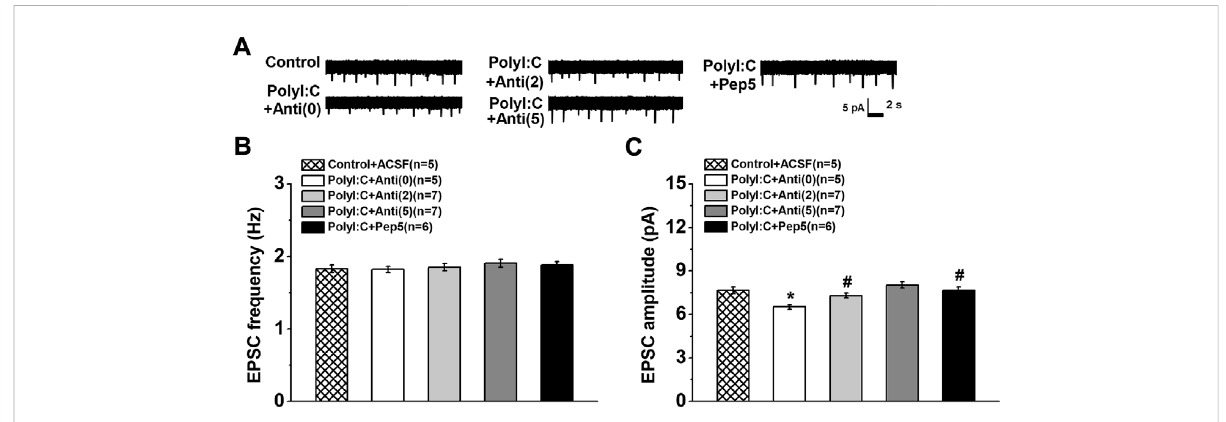
FIGURE 4 (A) ThechangesinEPSCofprymidalCA1neurons.TypicalconsecutivesampletracesofsEPSCsfromeachgroup(Top).ThefrequencyofsEPSC (B) is not altered but the amplitude of sEPSC (C) is decreased in polyI:C-treated offspring. Incubation with anti-proBDNF antibody or TAT-Pep5 inhibitor can signi fi cantly enhance the declined amplitude. Data are presented as mean ± SEM. * p < 0.05, vs. Control + ACSFCA1, PolyI:C + AntiCA1andPolyI:C+Pep5CA1.Control+ACSFCA1: n =5;PolyI:C+ACSFCA1: n =5;PolyI:C+AntiCA1: n =7;PolyI:C+AntiCA3: n =7;PolyI:C + Pep5CA1: n =